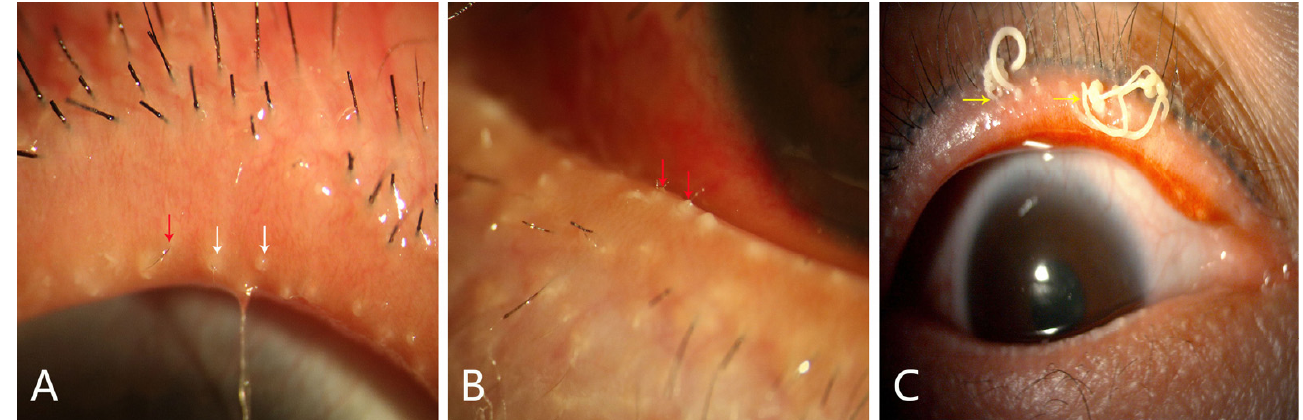
Figure 3. Eyelid of a 29-year-old female with MGD-EDE, showing keratinized marginal conjunctiva, inspissation of duct orifices (( A ), white arrows) with hair growth from MGs (( A , B ), red arrows). A 35-year-old female with MGD shows expressible highly viscous meibum (( C ), yellow arrow).